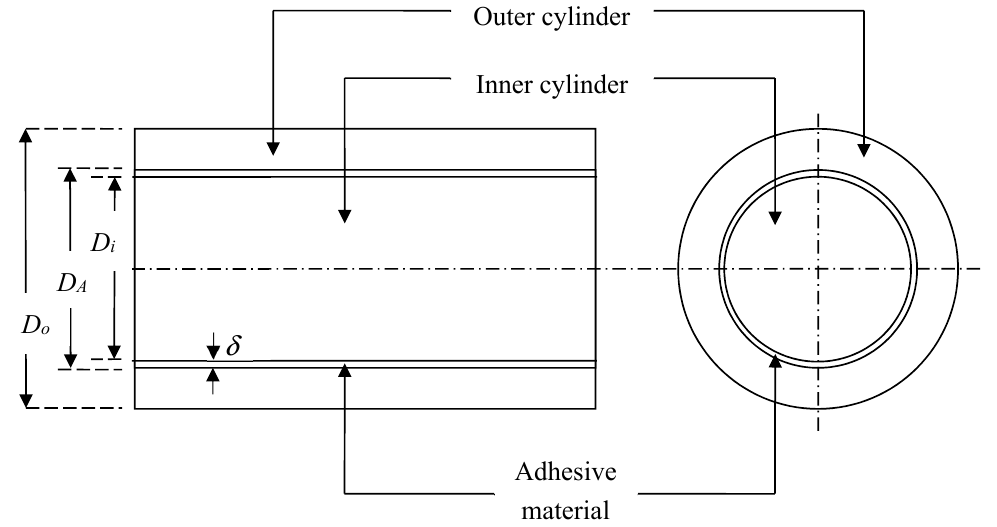
Figure 3. Side ( left ) and axial ( right ) views of a rod made from two concentric foams with opposite Poisson’s ratio signs, in which the adhesive material is assumed to take on the shape of a thin cylindrical shell.